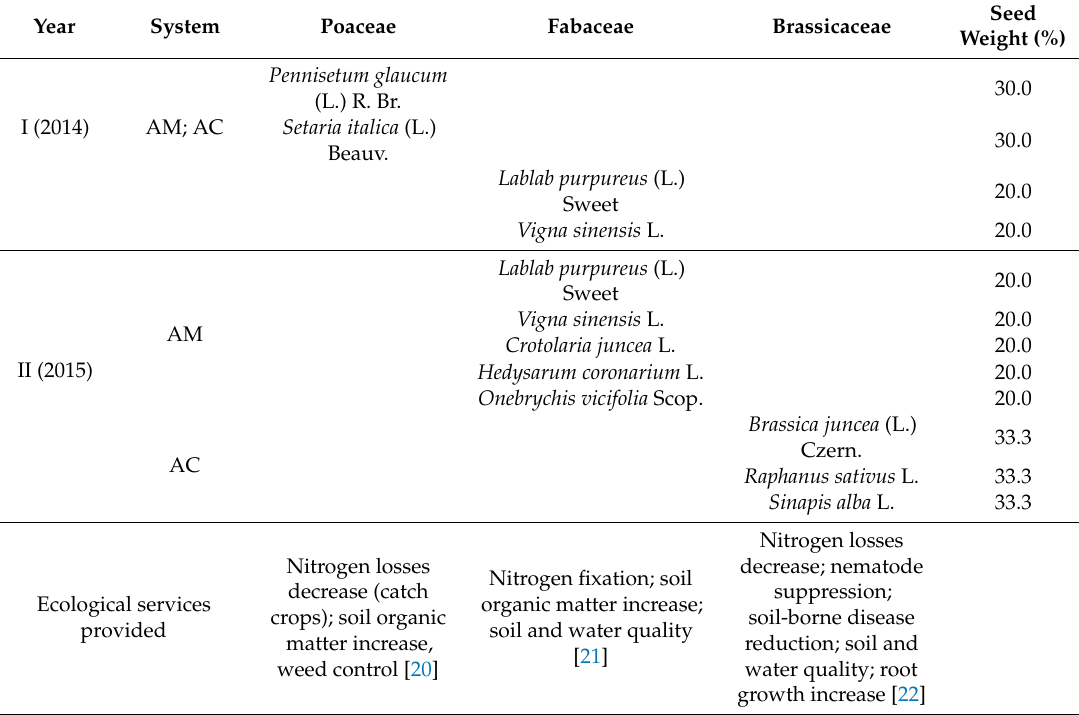
Table 1. Agroecological service crops (ASC) mixture composition and ecological services